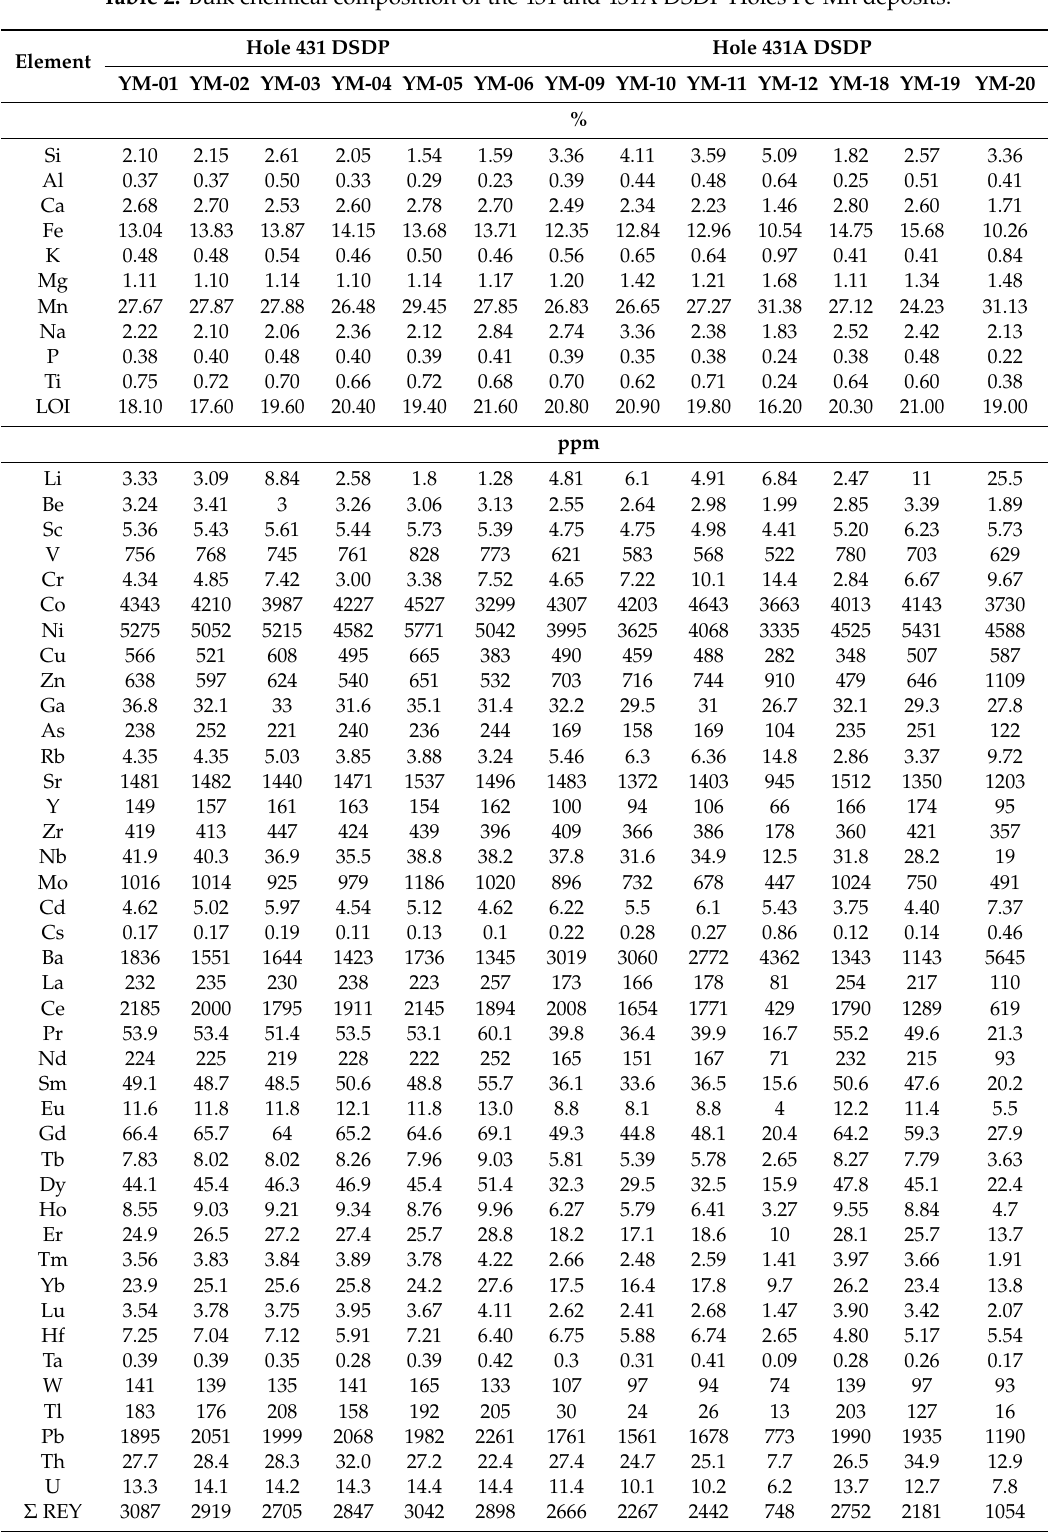
Table 2. Bulk chemical composition of the 431 and 431A DSDP Holes Fe-Mn